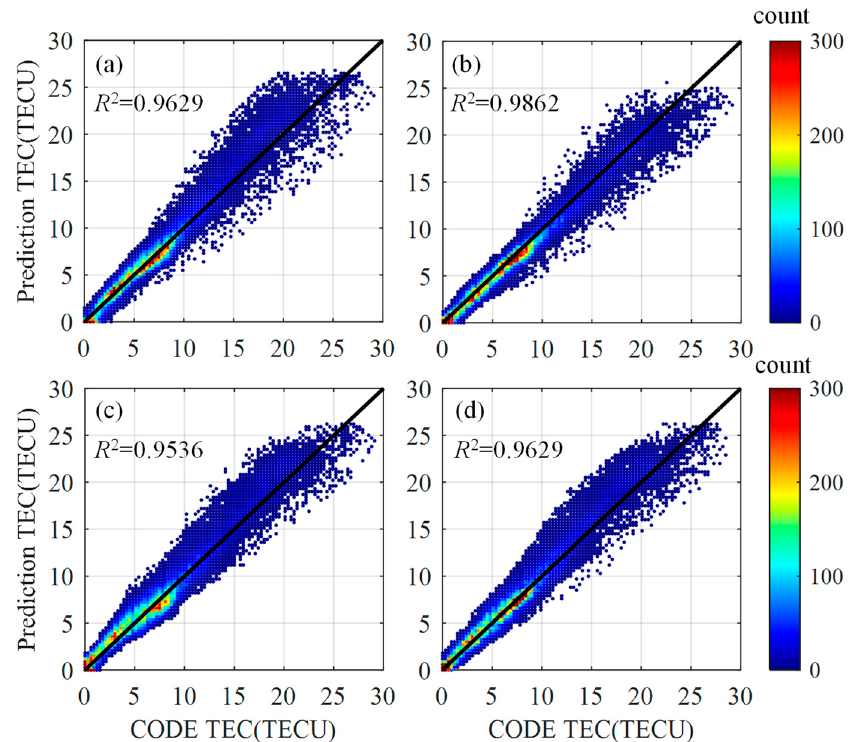
Figure 4. Correlation analysis between forecasted values and CODG values on 2 June in a year of low solar activity. ( a – c ) Scatter density plots of the correlations between the 7-day, 15-day and 30-day Prophet model forecasted values, respectively, and the CODG values. ( d ) Scatter density plot of the correlation between the COPG and CODG values.